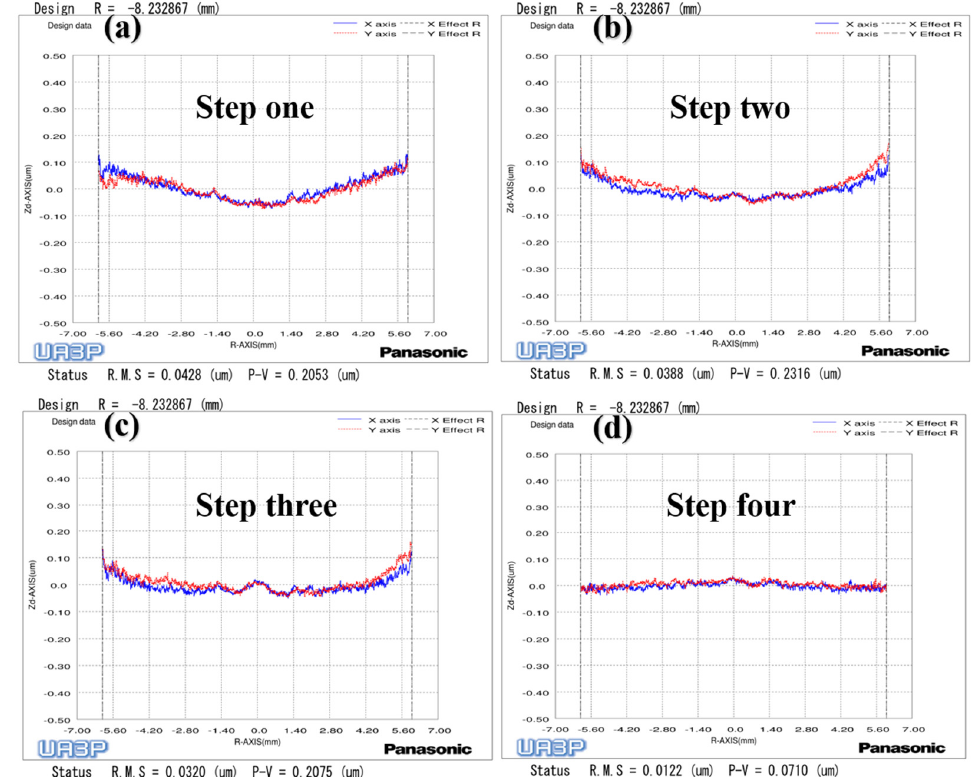
Figure 17. Surface shape change process of aspherical mold two: ( a ) Grinding ( b ) Polishing with small polishing disc tool; ( c ) Polishing with constant rotation speed mode; ( d ) Polishing with variable speed mode.